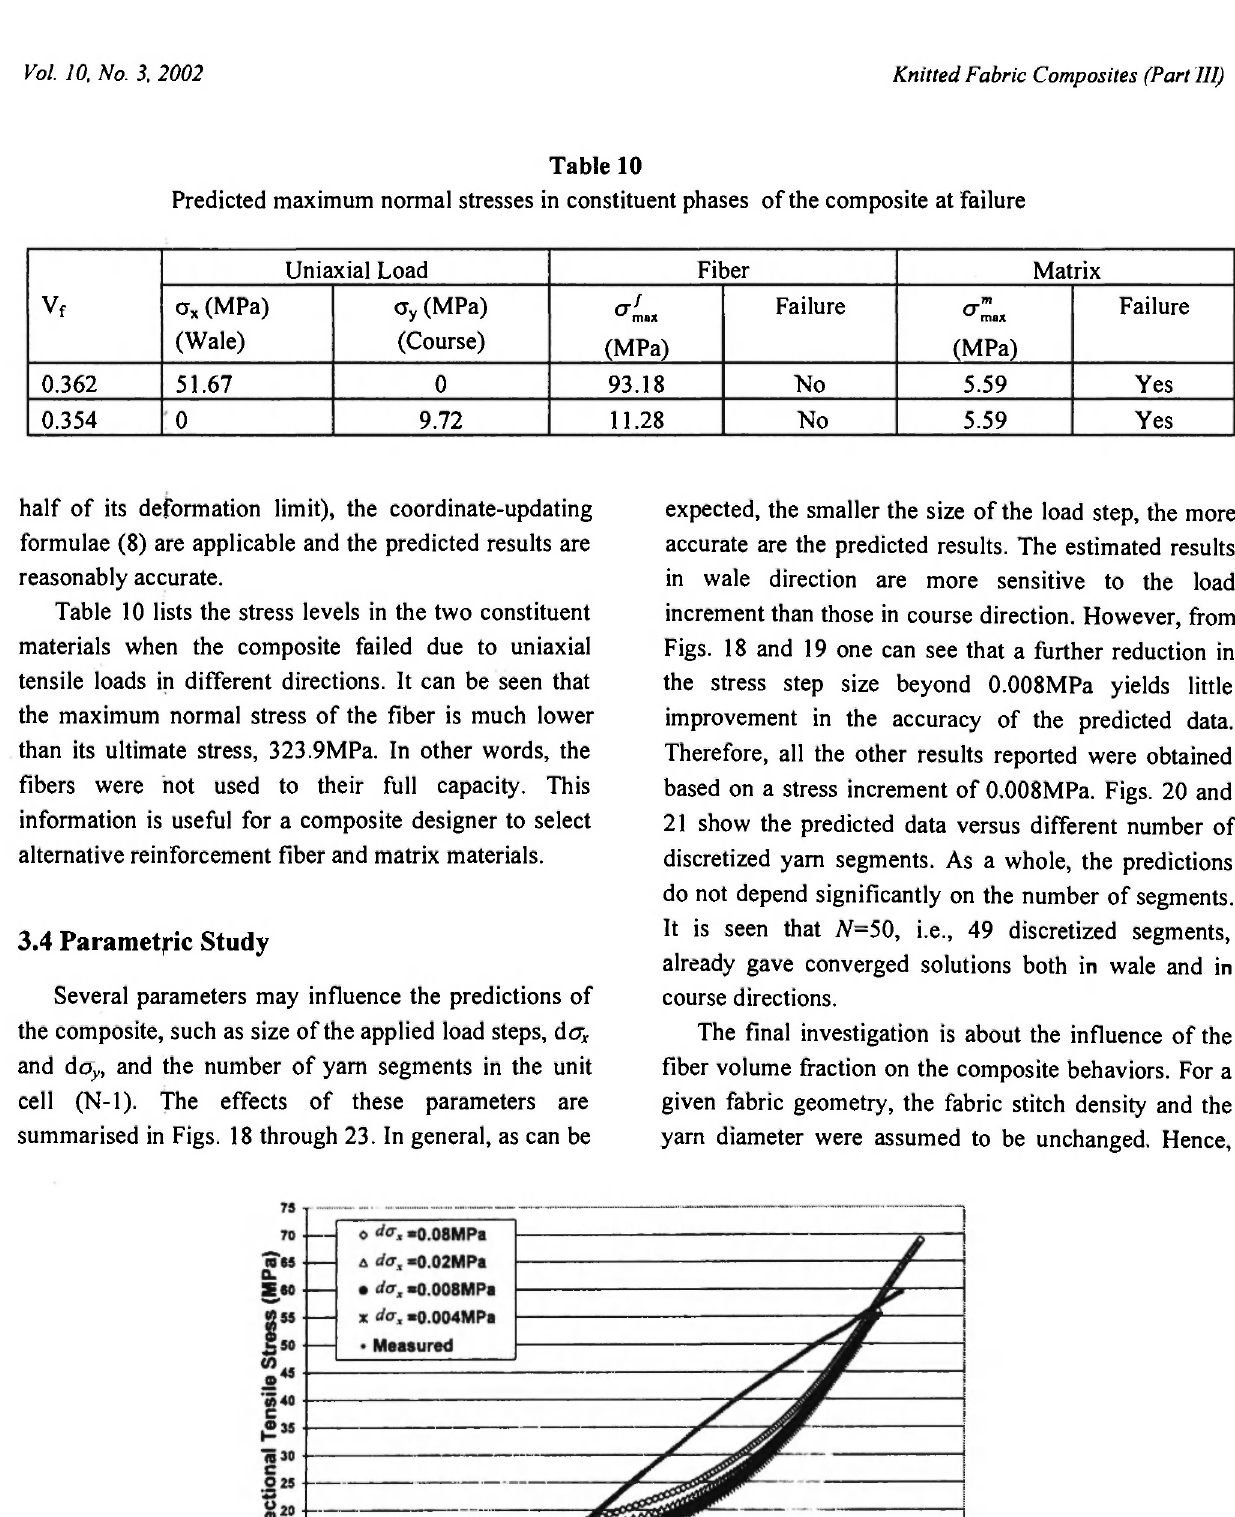
Influence of size of stress step on predicted stress-strain curves in wale direction. The parameters used are: K/=0.362 and N=